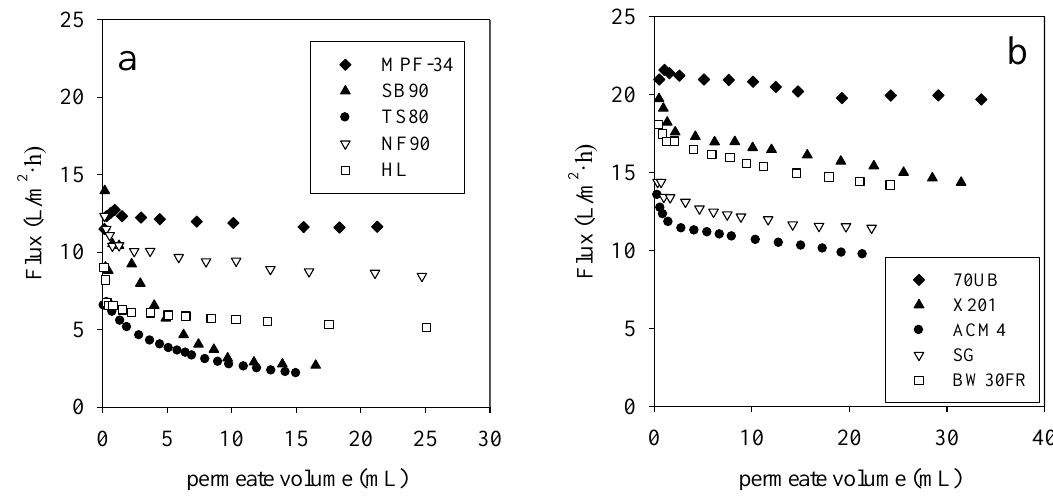
Figure 2. ( a ) Flux measurements by direct-flow filtration using NF membranes and ( b ) flux measurements by direct-flow filtration using RO membranes. Transmembrane pressure (TMP) was adjusted for each membrane to achieve a constant initial flux for all of the membranes. Using constant initial flux enables direct comparisons among membranes.